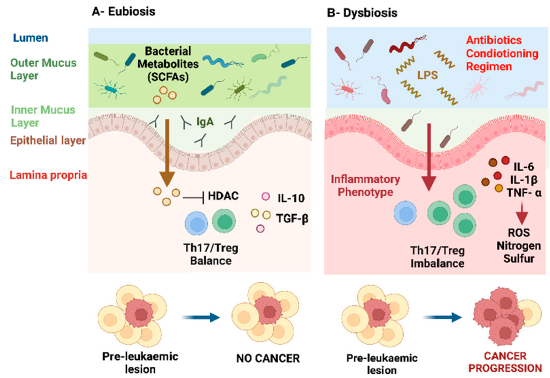
Figure 1. Involvement of the gut microbiota on leukaemia progression. ( A ) Eubiosis. Pre-leukaemic clones can arise in genetically predisposed individuals (for example Pax5 heterozygosity and the ETV6-RUNX1 fusion in acute lymphoblastic leukaemia, ALL), but an intact microbiota can protect from the development of leukaemia. The gut microbiota can modulate the host metabolism, inflam- mation, and immune responses, and it is involved in the maintenance of the intestinal barrier. Here is represented the distal colon containing two mucus layers: the outer mucous layer containing the gut microbiota, and a stratified adherent inner mucus layer essentially sterile. The microbiota produces metabolites, including Short Chain Fatty Acids (SCFAs). They are involved in the maintenance of the intestinal epithelial barrier, suppress inflammatory cytokines, and control host immunity through epigenetic changes. SCFAs can inhibit the Histone Deacetylase Activity (HDAC) inducing the differentiation of Forkhead box protein P3 (FOXP3)+ Regulatory T cells (Tregs), and maintaining a balance between Tregs and T-helper 17 (Th17) cells. Tregs produce the anti-inflammatory cytokines Interleukin (IL)-10 and Transforming Growth Factor beta (TGF- β ). ( B ) Dysbiosis. Alterations of this delicate balance can induce disease progression. Antibiotics, a conditioning regimen, as well as a change in diet or medication, can induce a loss of beneficial bacteria, with increase in pathological bacteria. Lipopolysaccharide (LPS)-producing bacteria are increased, inducing mucositis, disruption of the mucus layer, and break of the epithelial barrier. Pathogens can therefore invade the lamina propria and activate immune responses, with imbalance of Treg and Th17 cells, and secretion of proinflammatory cytokines, such as IL-1 β , IL-6, TNF- α . They in turn stimulate the production of reactive oxygen species (ROS), nitrogen and sulphur, causing oxidative damage, and leading to cancer progression. Created with BioRender.com. Licence obtained on 14 March